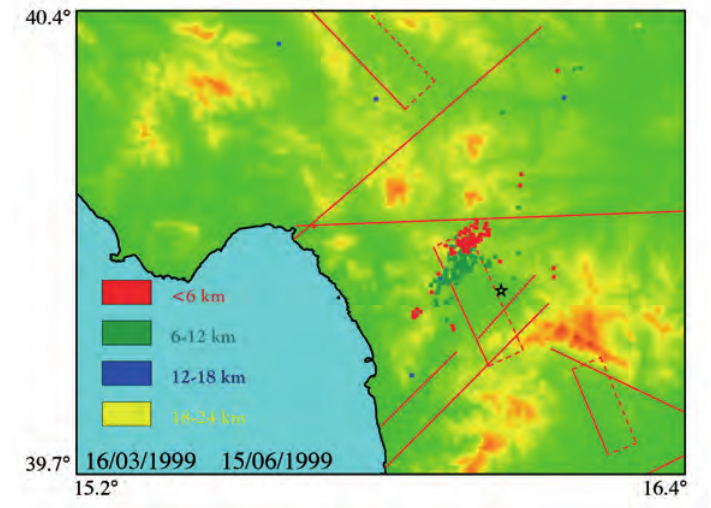
Fig. 13. Event locations in the time interval